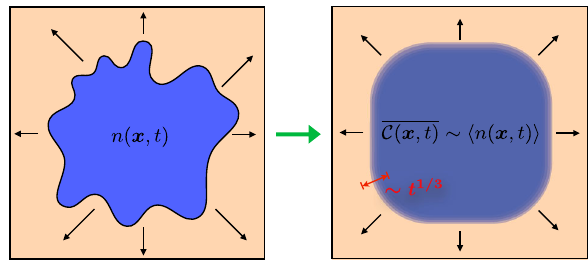
FIG. 6. Growth of a classical droplet and the OTOC: We relate the behavior of the OTOC (averaged over the unitaries in the circuit) to a classical stochastic process for the growth of a droplet in two spatial dimensions. A given configuration of the classical droplet is specified by a binary occupation number n ð x ; t Þ as shown on the left. Remarkably, the average droplet profile h n ð x ; t Þi precisely reproduces the averaged